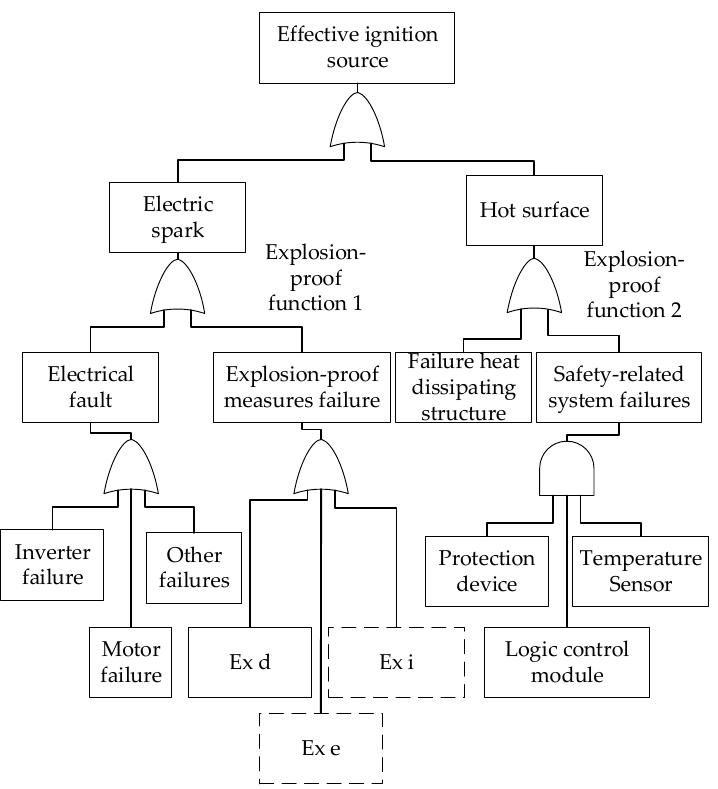
Figure 6. Fault tree analysis of Explosion protection VFD system.